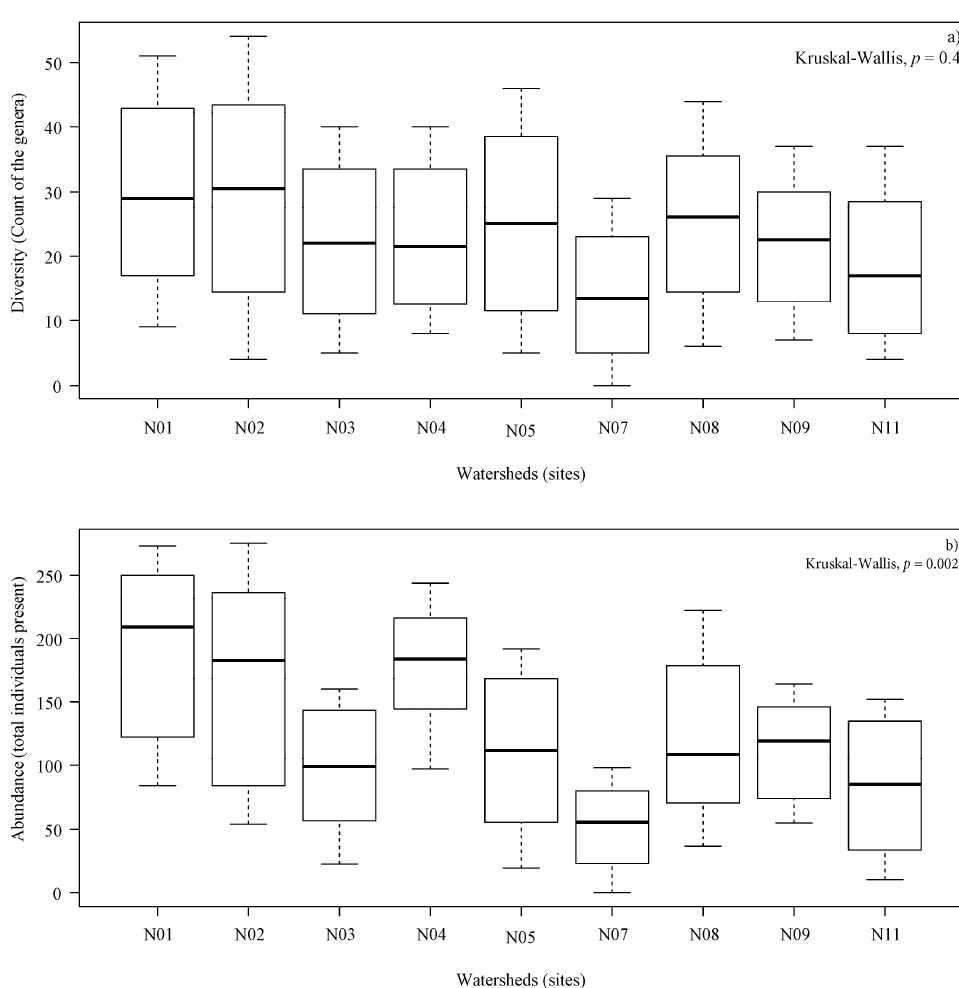
Figure 2. ( a ) Distribution of diversity (count of the genera) and ( b ) Distribution of abundance (total individuals present) in each watershed collected, 8 samples per watershed during sampling between 10 November 2015 and 18 August 2016. In ( a , b ), p -value using Kruskal–Wallis nonparametric test. The line within each box indicates the median value, box ends are the 25th and 75th percentiles, and the whiskers show the largest value within a 1.5 interquartile range from third quartile and the minimum value.